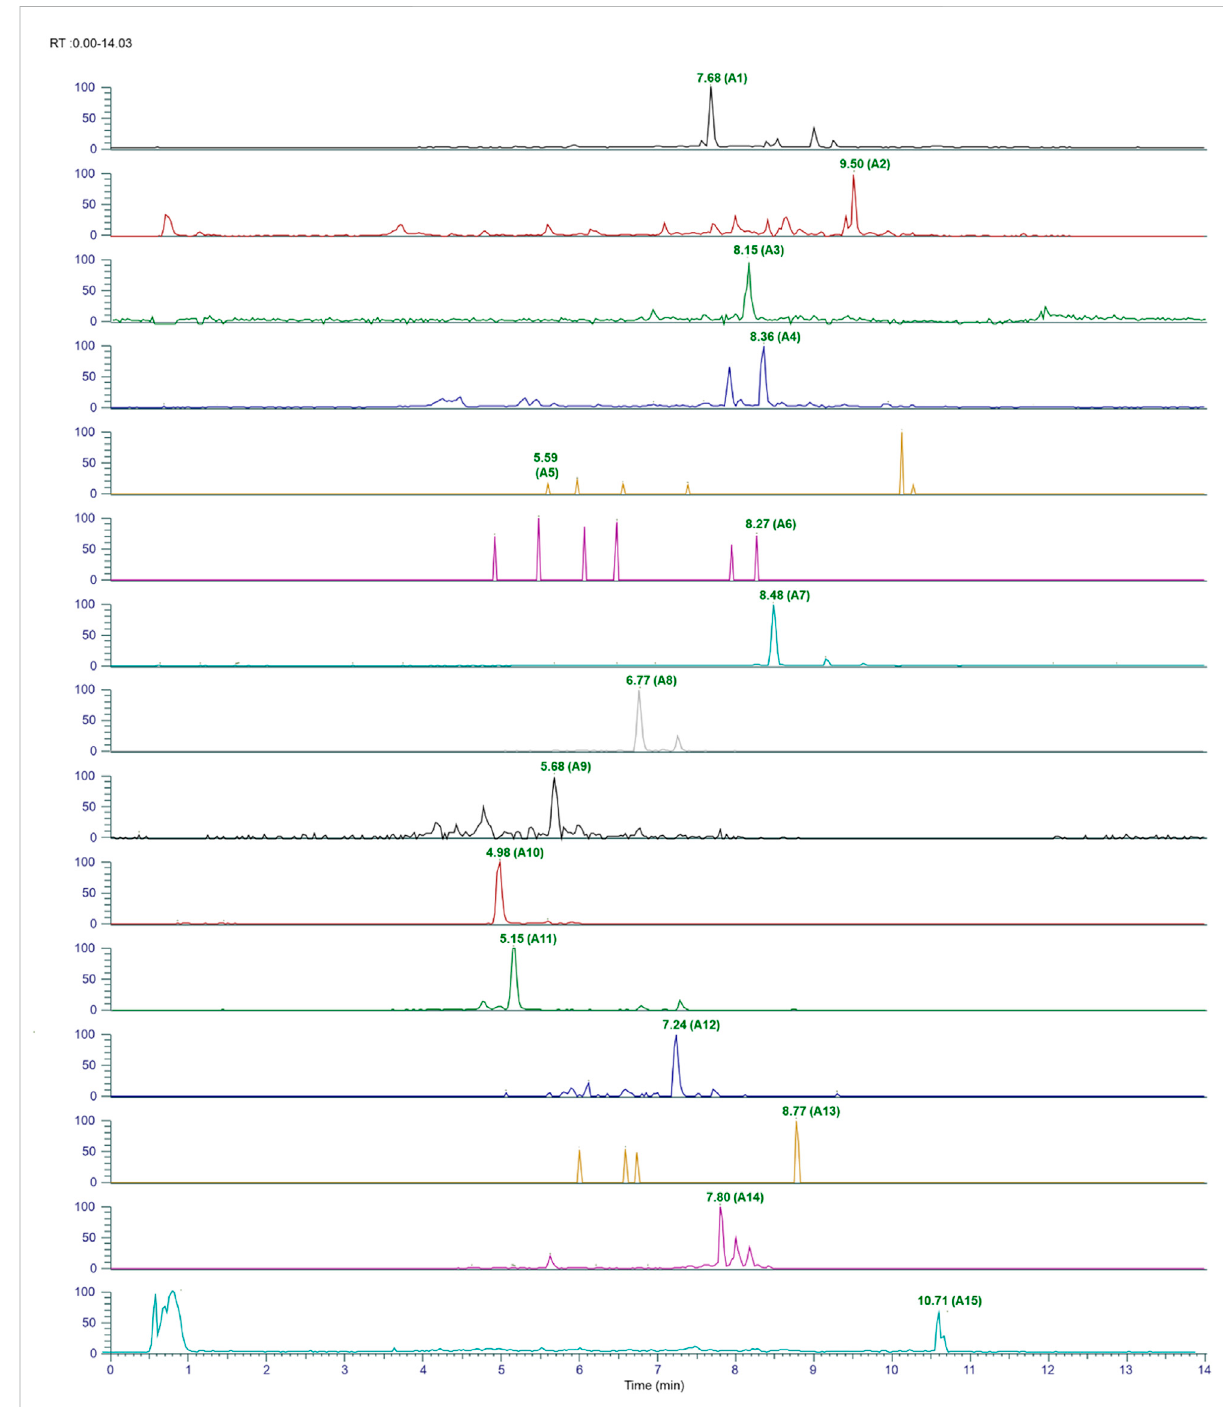
FIGURE 1 Chromatograms of identi fi ed phytoconstituents of AYUSH-64 in the positive ion mode. Betulin (A1), neocaesalpin B (A2), formononetin (A3), burnamine (A4), picrinine (A5), vallesamine (A6), oleanolic acid (A7), amarogentin (A8), gentianine (A9), mangiferin (A10), and sweroside (A11) and (1b) comprising A (12 – 24); kaempferol (A12), 5-methoxystrictamine (A13), neocaesalpin L (A14), and beta-caesalpin